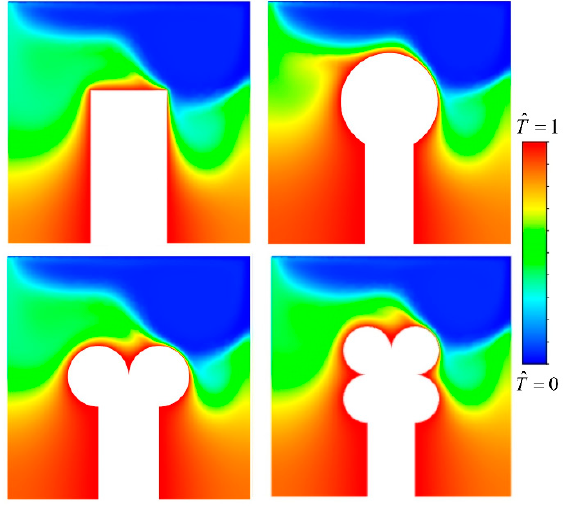
Figure 13. Thermal contours for each of the fins at Re = 1000 and Ra = 10 3 , showing the impact of increased top edge velocity.